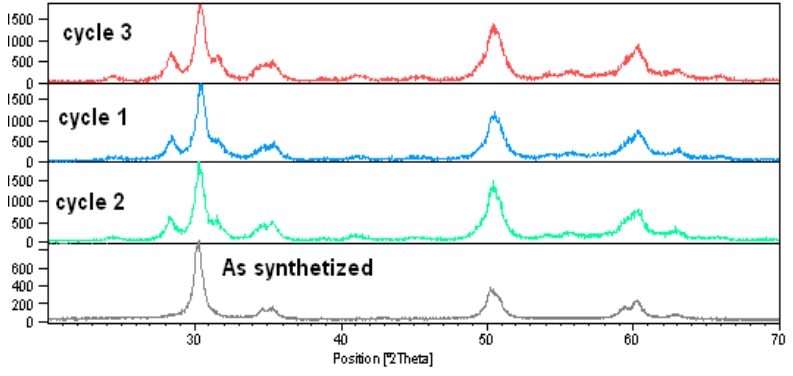
Figure 9. XRD patterns of reactivated SZ.